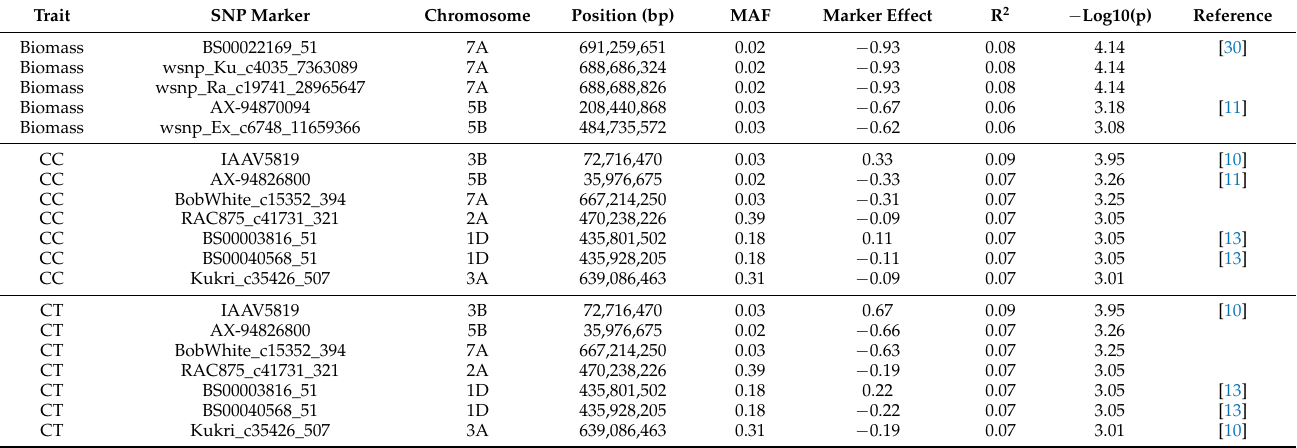
Table 3. List of the significant markers associated with Biomass, CC, CT, DHE, DMA, GY, NPM, NSS, NTP, PLH, and TKW from genome-wide association analysis of 200 bread wheat genotypes under the irrigated conditions at Sidi Al-Aidi